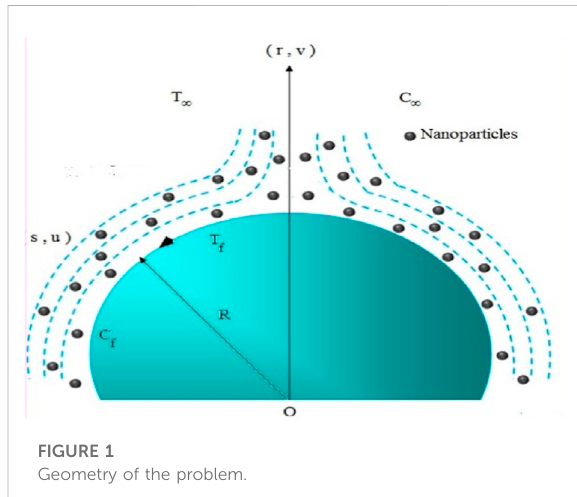
FIGURE 2 Disparity of M on f ′ .